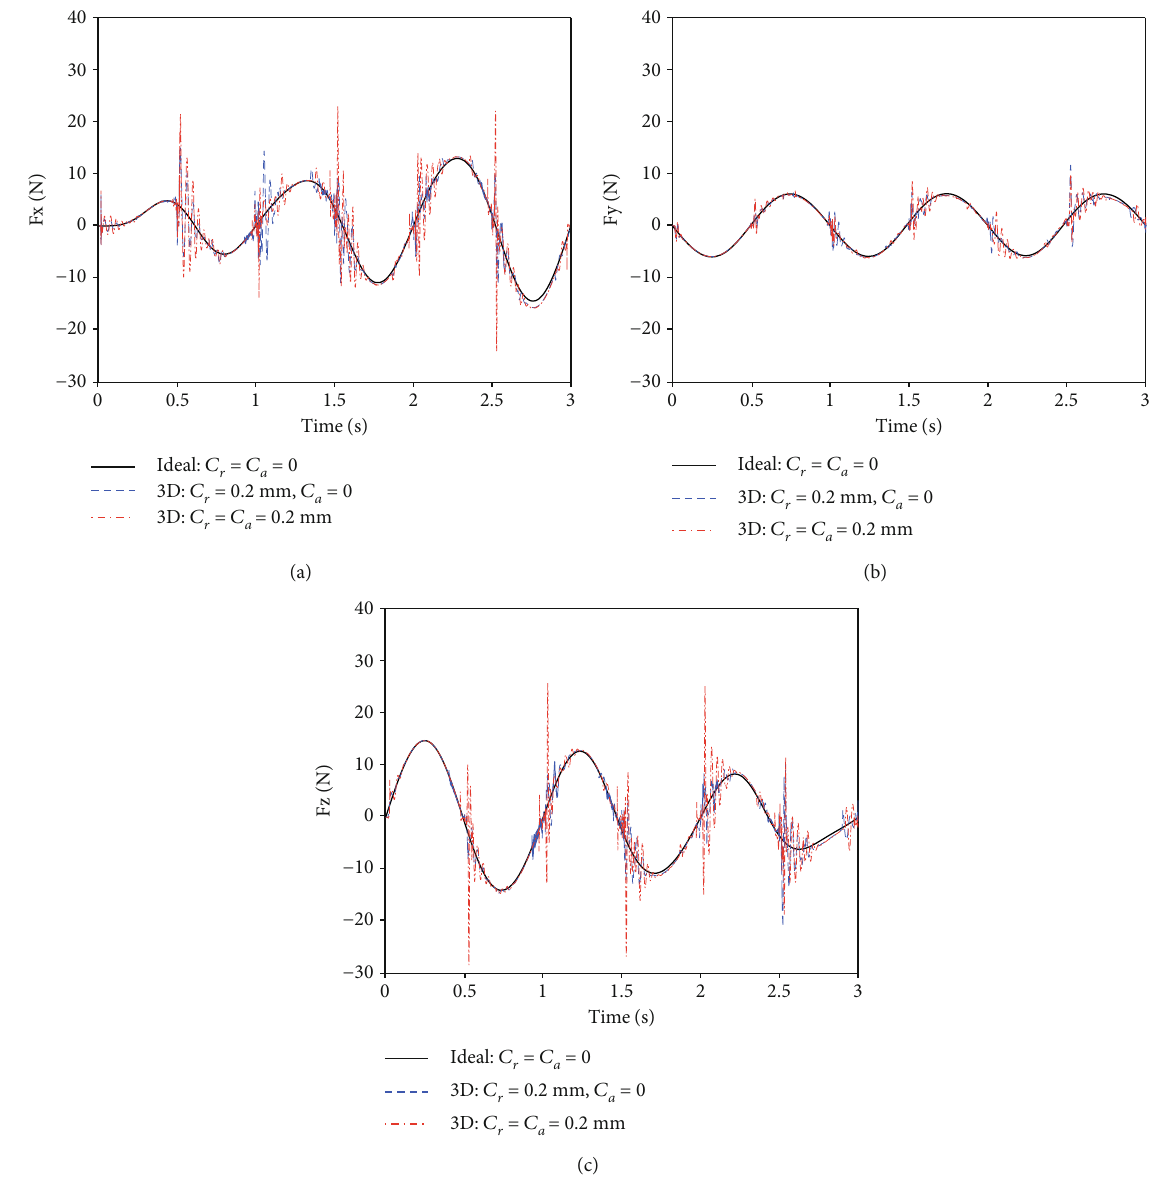
Figure 10: Contact forces in 3D revolute clearance joint.